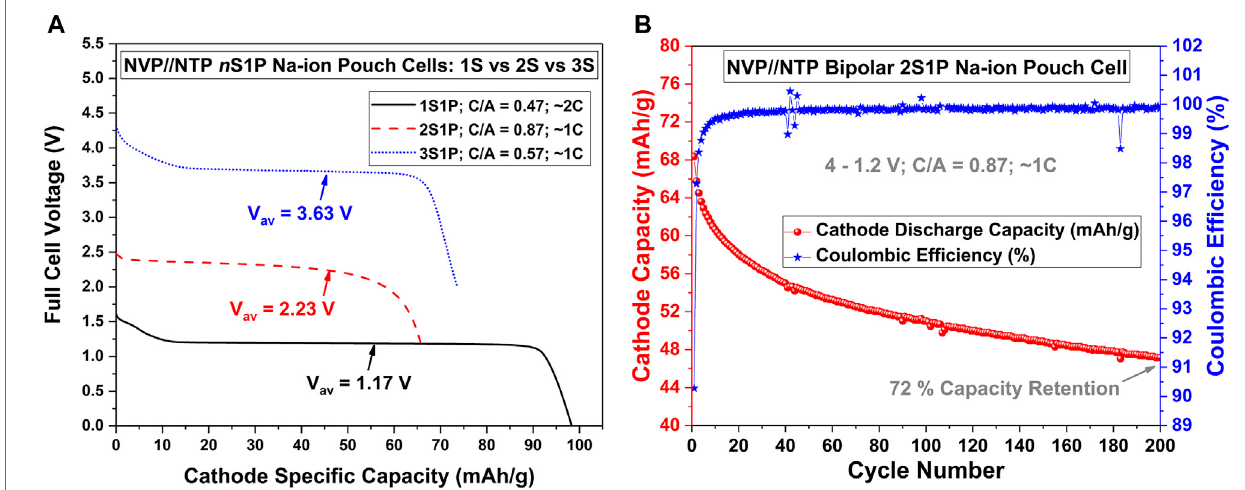
FIGURE 1 | Performance of n S1P Bipolar NVP//NTP Na-ion Pouch Cells. (A) Comparison of the cycling curves of 1S1P, 2S1P and 3S1P NVP//NTP pouch cells using2 cm×2 cmcathodes.Notethat “ C/A ” referstotheratiooftheactivematerialinthecathodetothatoftheanode.Thefullcellcyclingvoltagelimitsforthethreecells were as follows: 1S1P (1.9 – 0 V), 2S1P (4 – 1.2 V) and 3S1P (4.9 – 2 V). (B) Cycling stability over 200 cycles for the 2S1P bipolar NVP//NTP Na-ion bipolar pouch